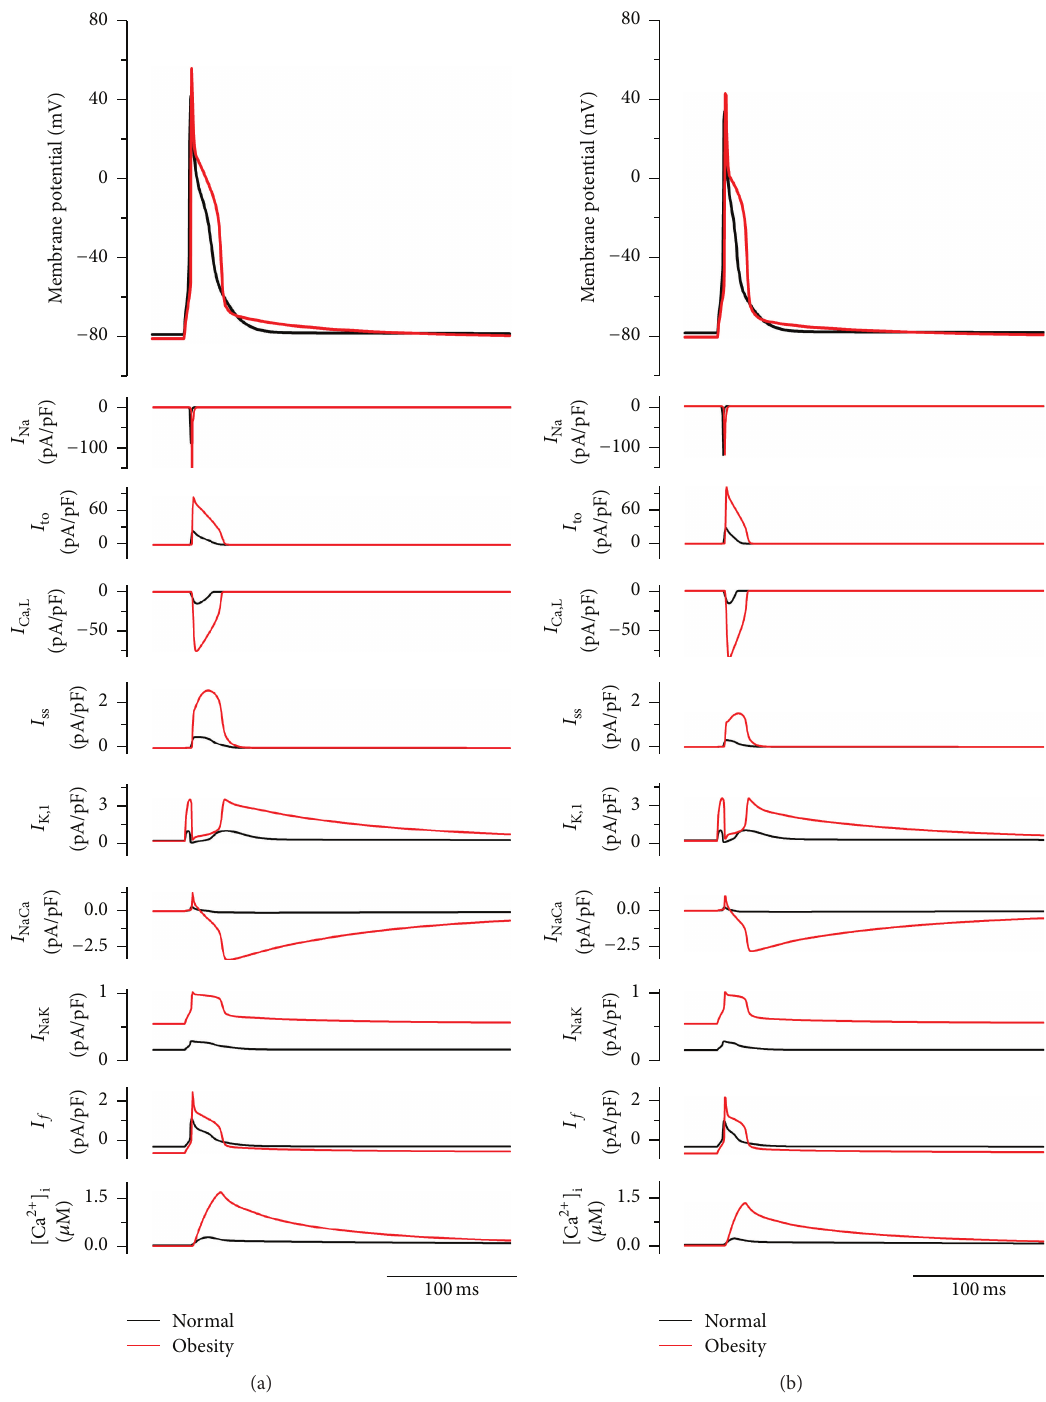
Figure 5: Simulated rat ventricular endocardial ((a) ENDO) and epicardial ((b) EPI) action potentials and underlying ionic currents and intracellular Ca 2+ concentration in control and obesity